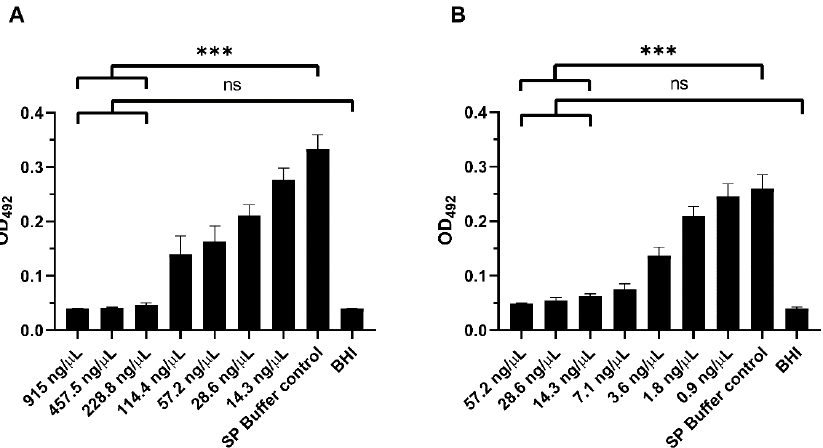
Figure 5. In vitro biofilm assays of S. pneumoniae R6 in BHI treated with 23TH_48 lysin in sodium phosphate buffer (SPB) measured with tetrazolium salt 2,3-bis[2 -methyloxy-4-nitro-5-sulfophenyl]- 2H-tetrazolium-5-carboxanilide (XTT) assay at OD 492 . As a control, cells were incubated in BHI with the addition of SPB instead of lysin. ( A ) Prevention of biofilm formation by 23TH_48 in